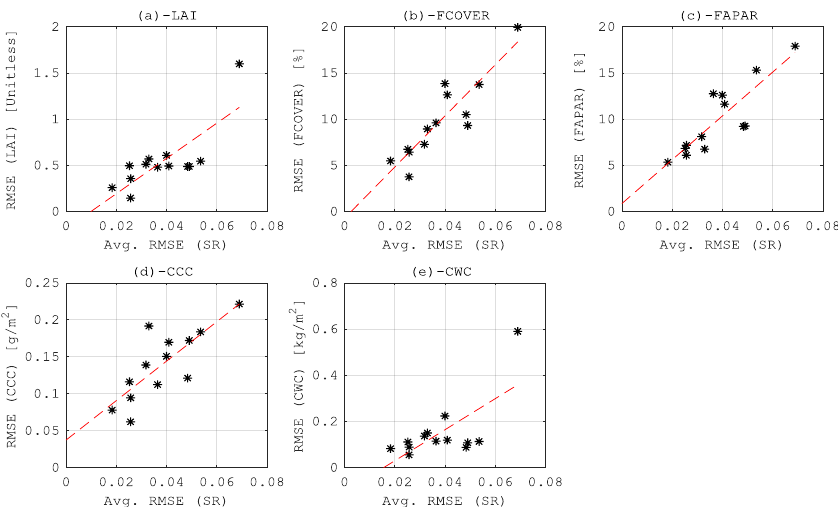
Figure 6. RMSE between pairs of vegetation biophysical variables derived from S2-LIKE and S2-MSI against the average of RMSE values obtained from the different spectral bands for the corresponding surface reflectance datasets.